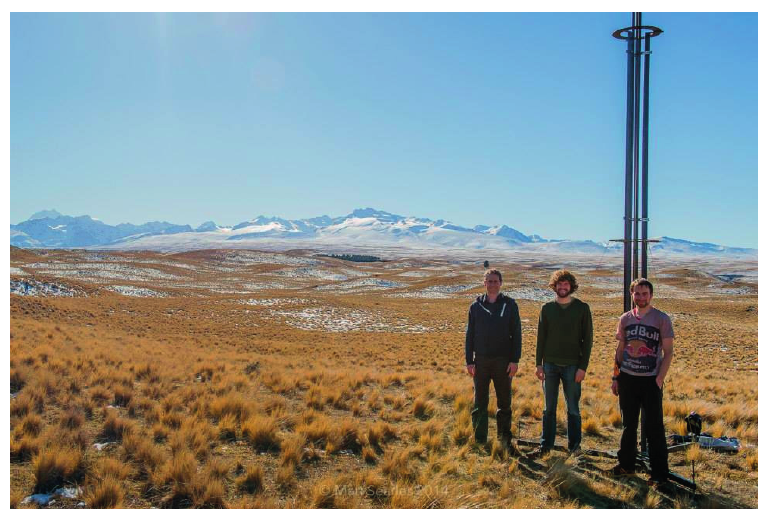
Figure 11. Launch guide and terrain with Mount Cook in background.